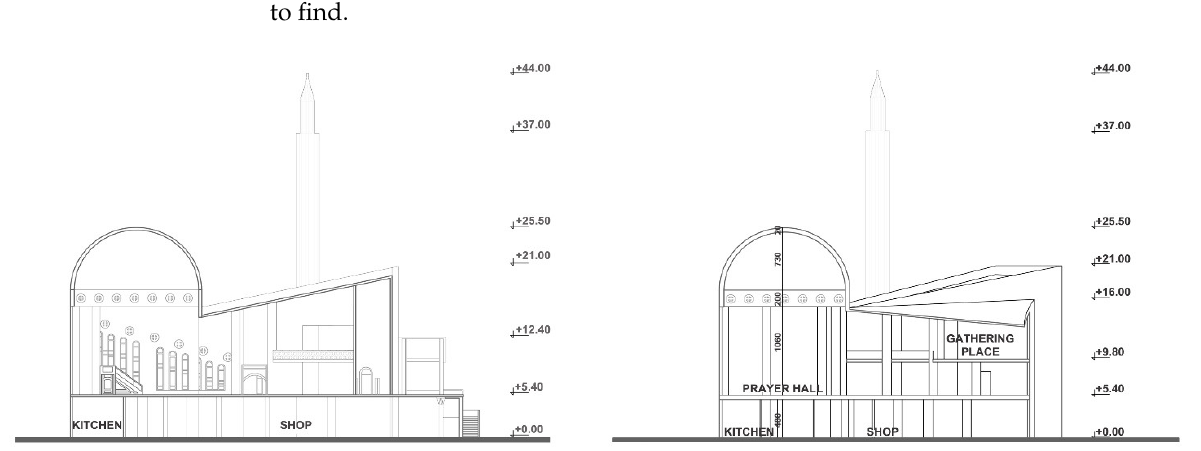
Figure 17. The Akdeniz Sanayi Mosque’s layout and ground floor plan .